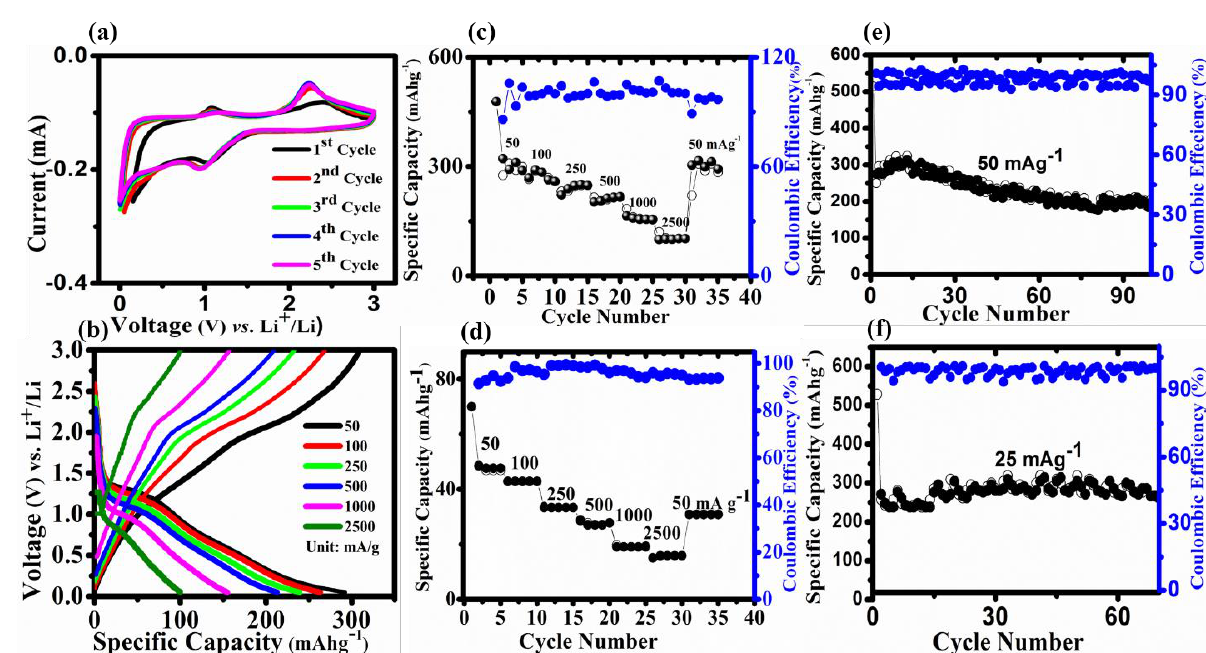
Figure 3. Electrochemical characterization of CSs@Se and CSs: ( a ) cyclic voltammetry (CV) of composite between 0.005-3 V at 0.5 mV s − 1 , ( b ) charging–discharging profiles of CSs@Se at different current rates (50–500 mA g − 1 ), ( c ) rate performance of CSs@se ( d ) rate performance of CSs, ( e ) cyclic stability after 100 cycles of CSs@Se at 50 mA g − 1 , and ( f ) cyclic stability after 70 cycles of CSs@Se at current density of 25 mA g − 1